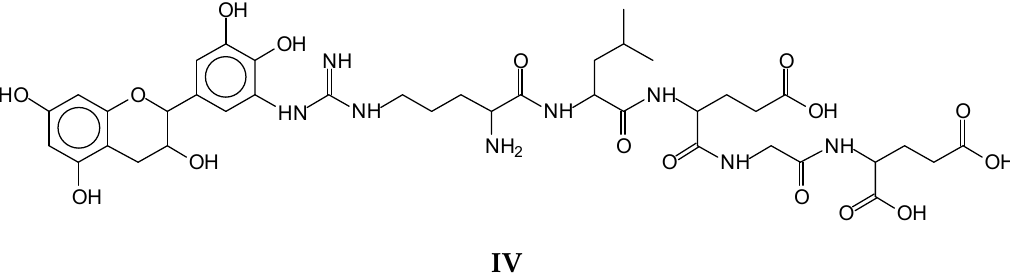
Figure 7. Example of an identified species ( IV ) indicating that cross-linking between a proteinand a tannin occurs. It depicts the species formed by reaction of a gallocatechin reacted with a peptide formed by arginine–leucine–aspartic acid–glycine–glutamic acid. The same peptide fragment is found linked to flavonoid dimers, as for example the